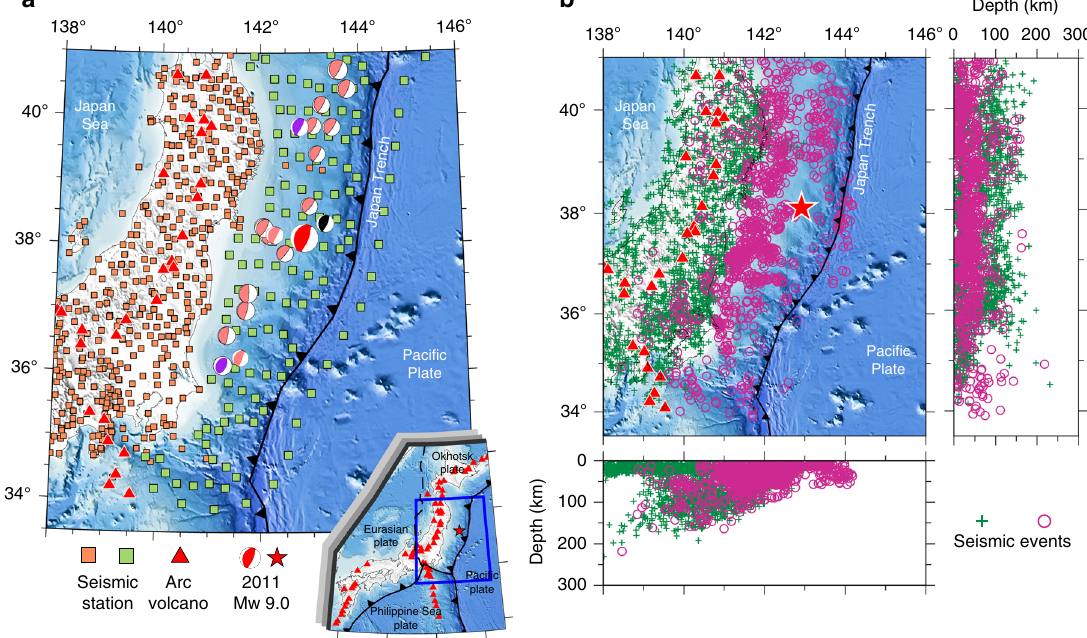
Fig. 1 Seismic stations and earthquakes used in this study. a Distribution of the 600 seismic stations used in this study. The orange squares denote 480 seismic stations that belong to the Hi-net. The green squares denote 120 S-net sea fl oor seismic stations. The red triangles denote active volcanoes. The red beach ball denotes focal mechanism of the great 2011 Tohoku-oki earthquake (Mw 9.0), whereas the pink beach balls denote focal mechanisms of other megathrust earthquakes ( M ≥ 7.0) that occurred during 1917 – 2017. The black beach ball denotes focal mechanism of the Tohoku-oki earthquake foreshock ( M 7.3) on March 9, 2011. The two purple beach balls denote focal mechanisms of two aftershocks ( M ≥ 7.5) of the Tohoku-oki earthquake on March 11, 2011. b Distribution of 3757 local earthquakes used in this study. The green crosses denote 2446 events recorded by the Hi-net. The purple circles denote 1311 events that were recorded by the S-net. The red star denotes the mainshock epicenter of the 2011 Tohoku-oki earthquake (Mw 9.0). The jagged black line denotes the Japan